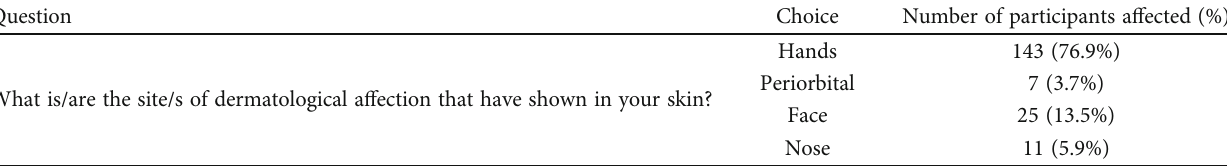
Table 6: The sites of dermatological a ff ection 186 of our total participants have